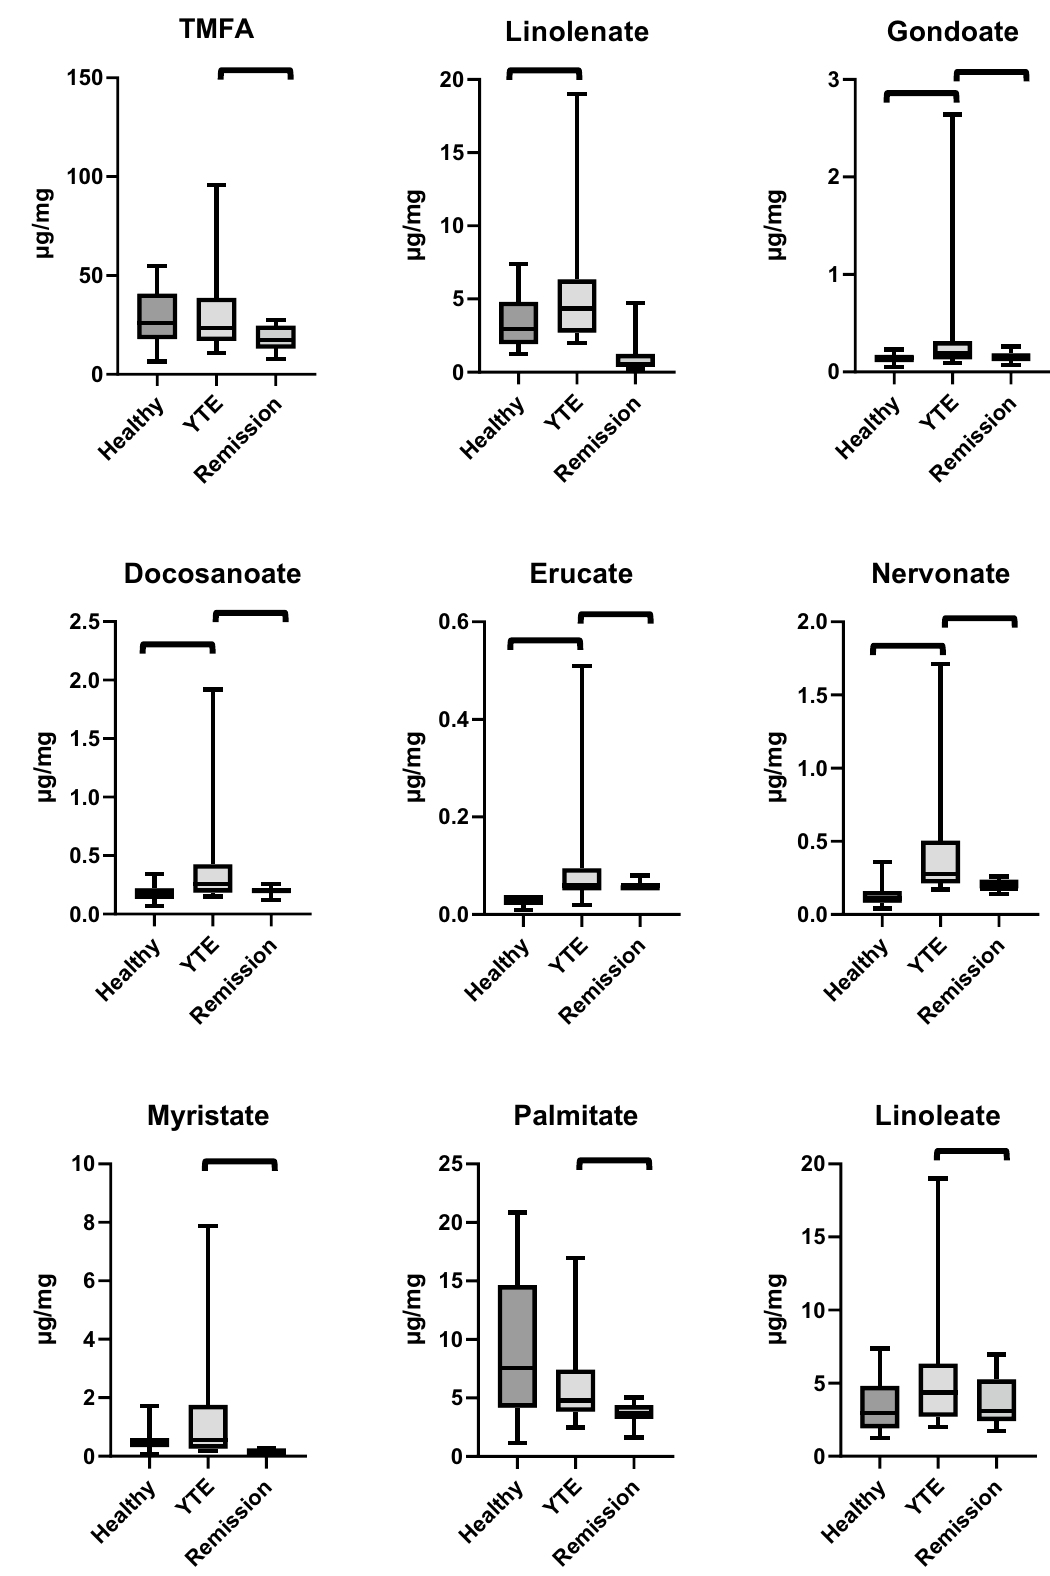
Figure 4. Box plots comparing fecal fatty acid concentrations in healthy controls, dogs with YTE, and dogs with YTE after achieving clinical remission. Square brackets are indicating significant differences between groups. Box plots represent the 25–75th percentile; the median is shown as the heavy dark horizontal line. Vertical lines extend to the minimum and maximum values. TMFA, total measured fatty acids; YTE, Yorkshire Terrier